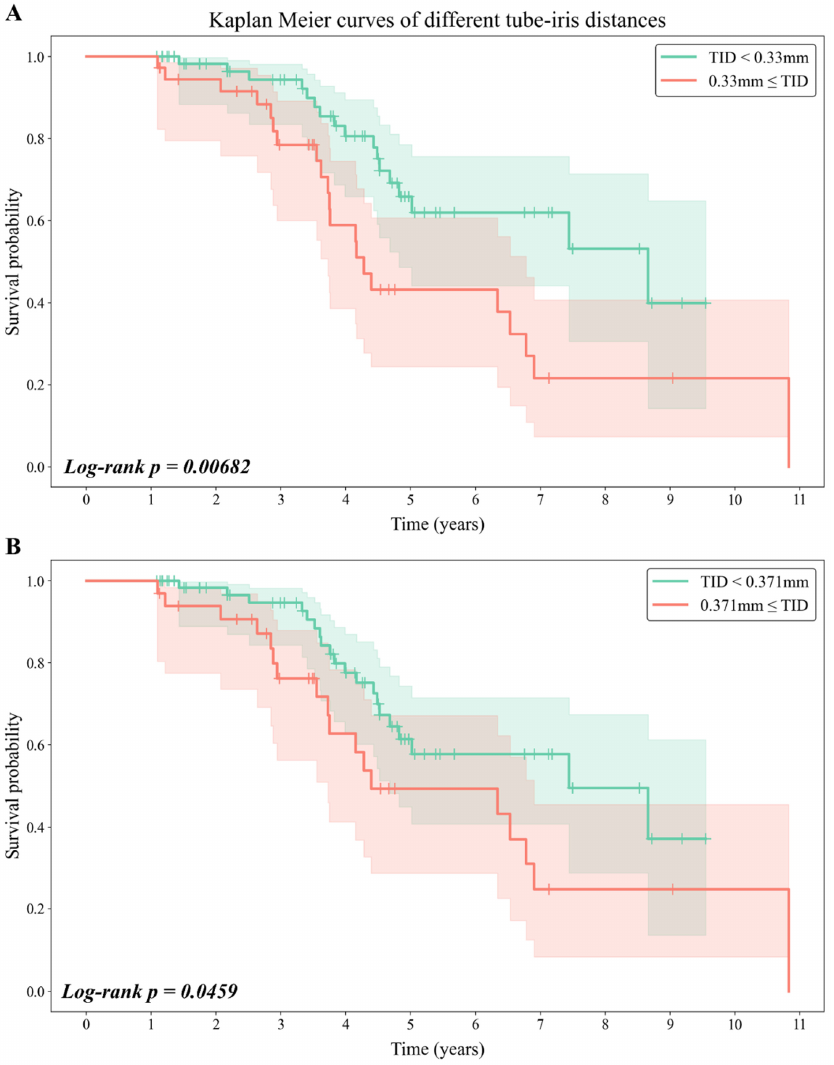
Figure 3. Kaplan–Meier curves of different tube–iris distances. Kaplan–Meier curves and log-rank tests were conducted for comparing patients with short or long tube–iris distances (TIDs), divided by the cut-off value determined from evaluations presented in Figure 2. Survival curves show sig- nificant difference with p-value of 0.00682 when 0.33mm is used as the cut-off ( A ). When 0.371mm is used as the cut-off, survival curves also show significant difference with p-value of 0.0459 ( B ).